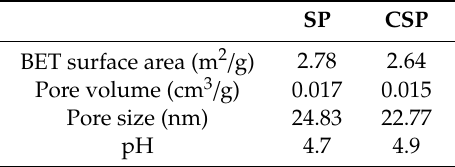
Table 2. Results of the X-ray fluorescence (XRF) analyses for SP and CSP.